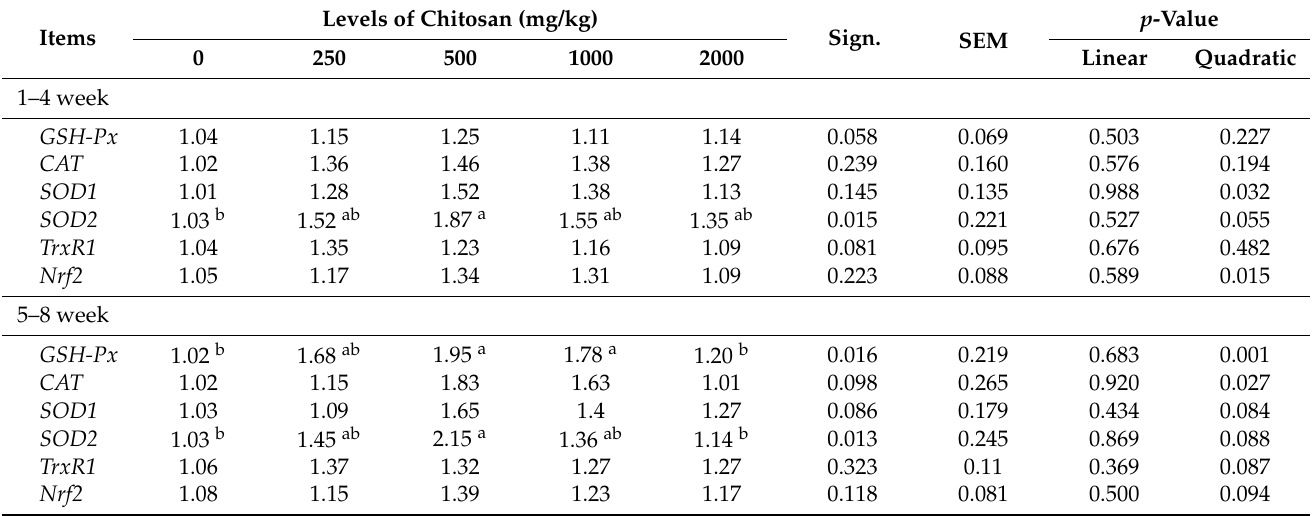
Table 6. Effect of dietary chitosan supplementation gene expression of antioxidant enzymes in